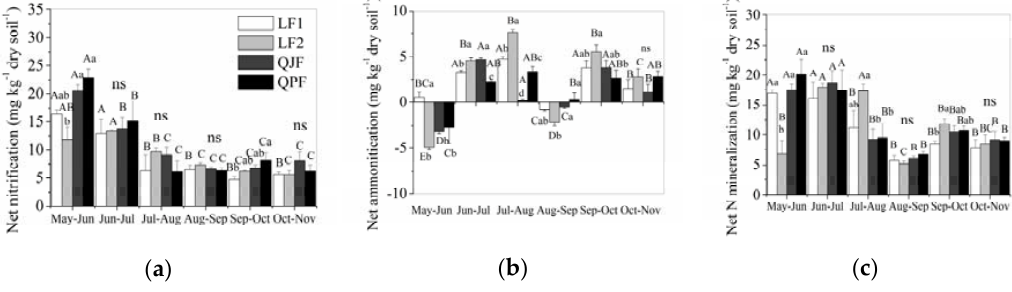
Figure 3. Rates of nitrification ( a ), ammonification ( b ) and net N mineralization ( c ) at one-month intervals (means ± SE, n = 3). Different lowercase letters indicate significant differences among forest types; different uppercase letters indicate significant differences among months (adjusted p < 0.05).